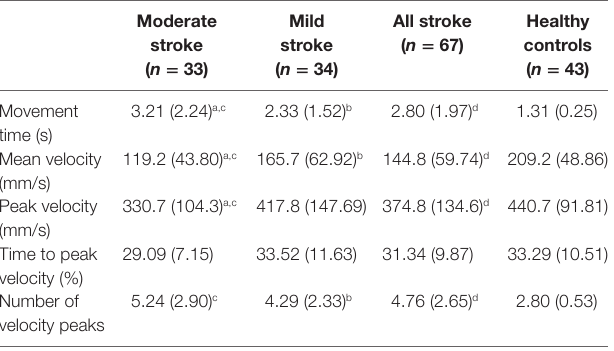
TaBle 2 | Mean and SD of kinematic variables for all participants during the target-to-target